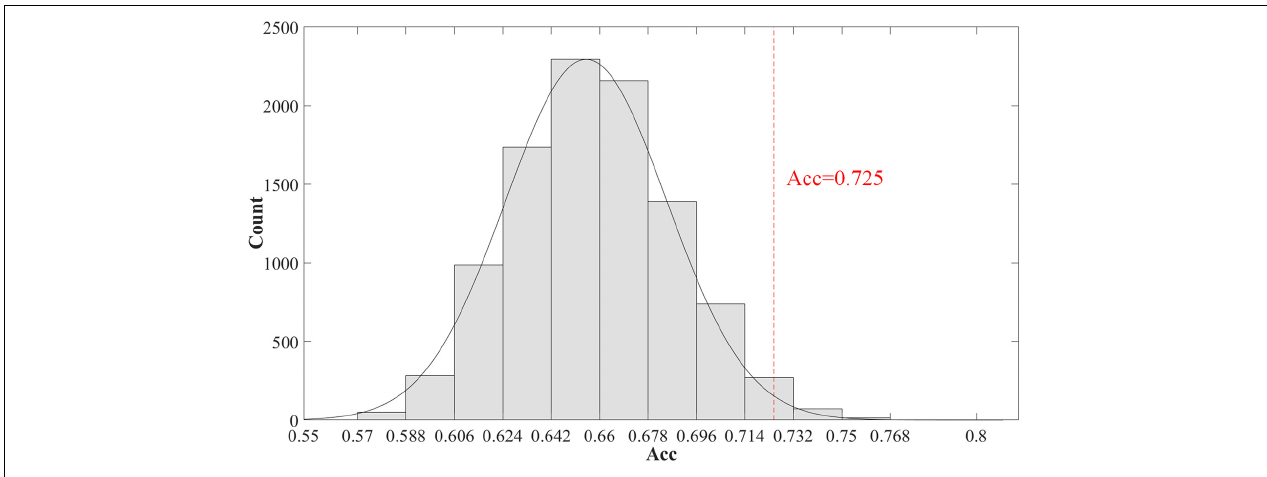
FIGURE 3 | The histogram of the accuracy of the permutation test. The permutation test with 10,000 times was used to evaluate the significance of our method. The accuracy of our method (0.725) is indicated by the red dotted line. The classification accuracy is higher than 96.4% of the permutated accuracy